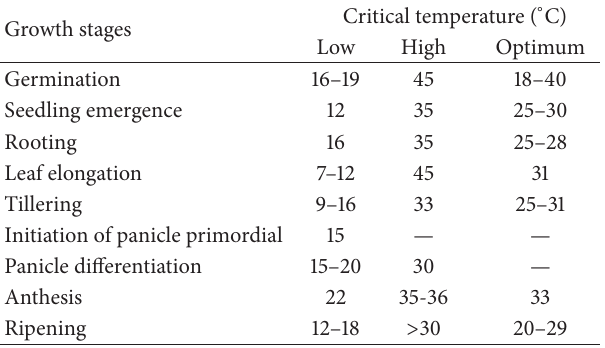
Table 6: Critical temperatures for the development of rice plant at different growth stages.